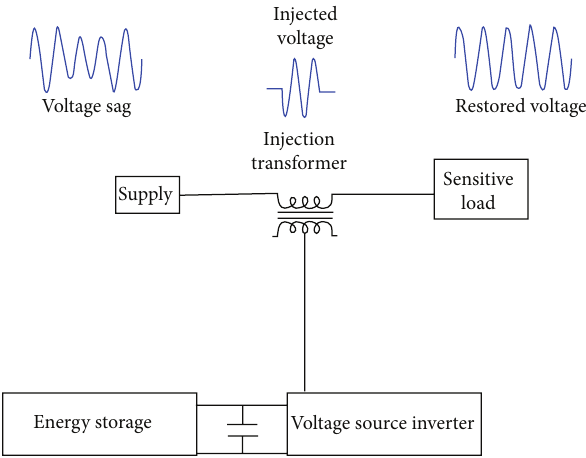
Figure 1: DVR operating